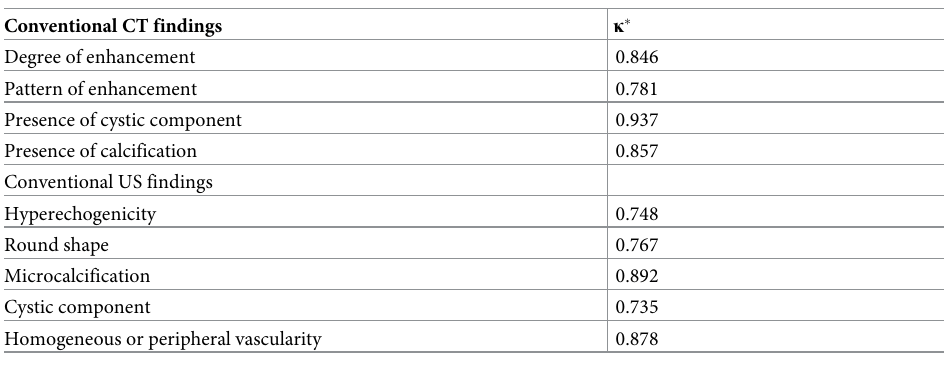
Table 3. Interrater agreement of conventional CT and US